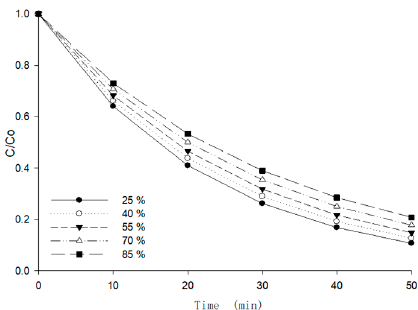
Figure 10. The effects of the moisture content on the anthocyanin retention ratio of berry puree. Table 5. Degradation rate constants and reaction heat of anthocyanin in berry puree in different moisture content.